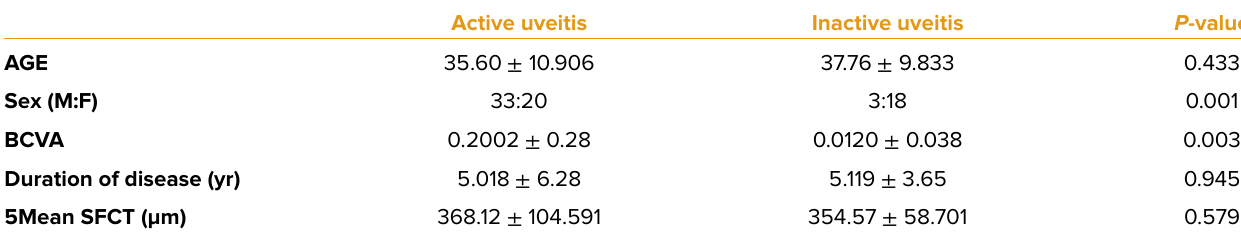
Table 2. Demographic and clinical finding of patients with ocular involvement only in WF-FAG Active uveitis Inactive